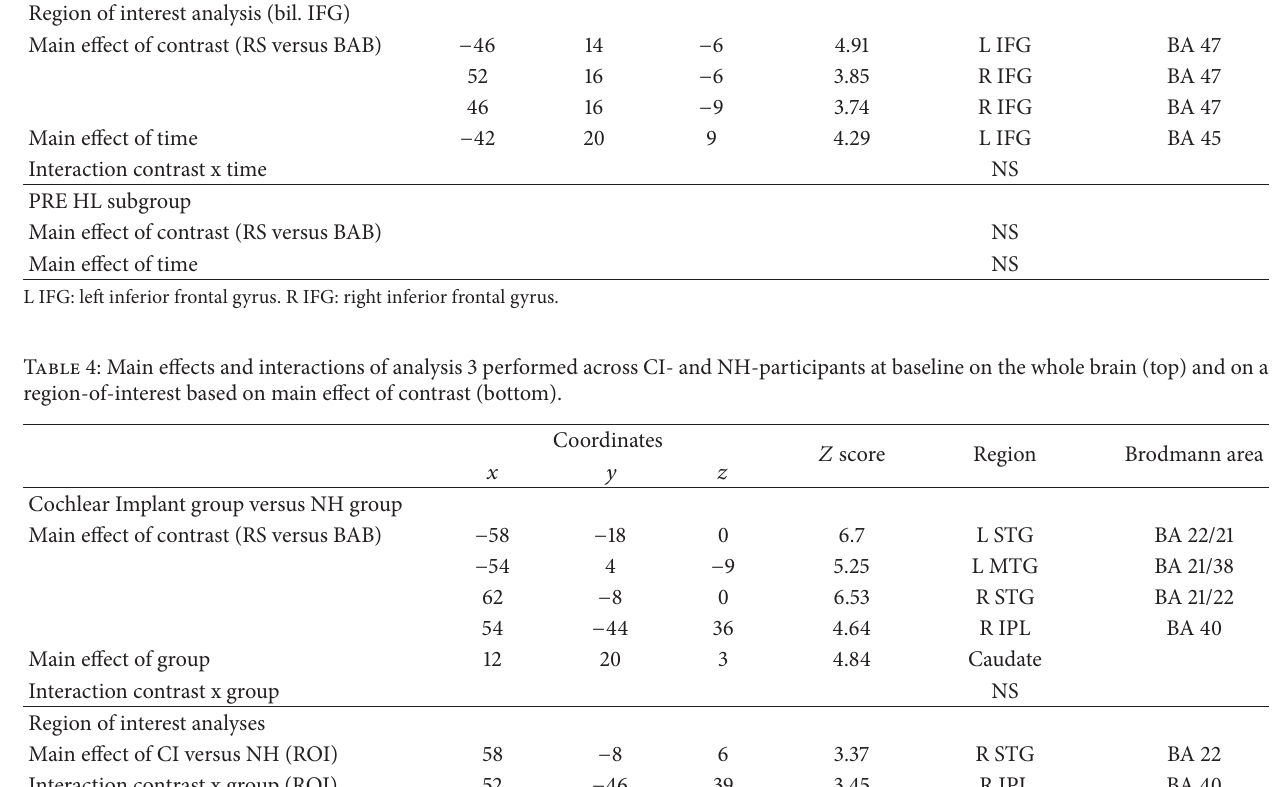
Table 3: Main effects and interactions of analysis 2 performed separately for the two CI-subgroups on a region-of-interest based on bilateral inferior frontal gyri.